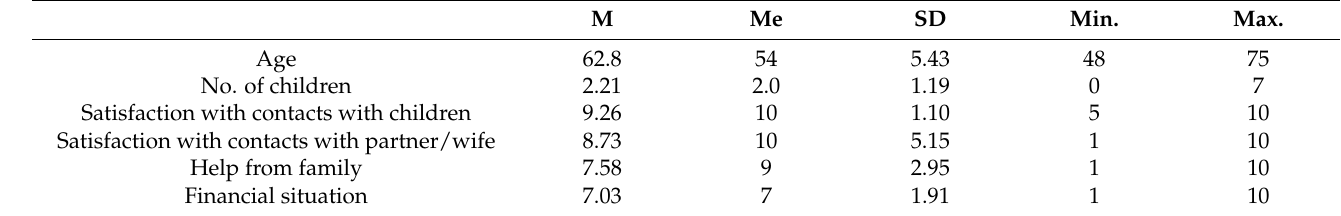
Table 1. Demographic data on age, number of children, and assessment of analyzed parameters of life